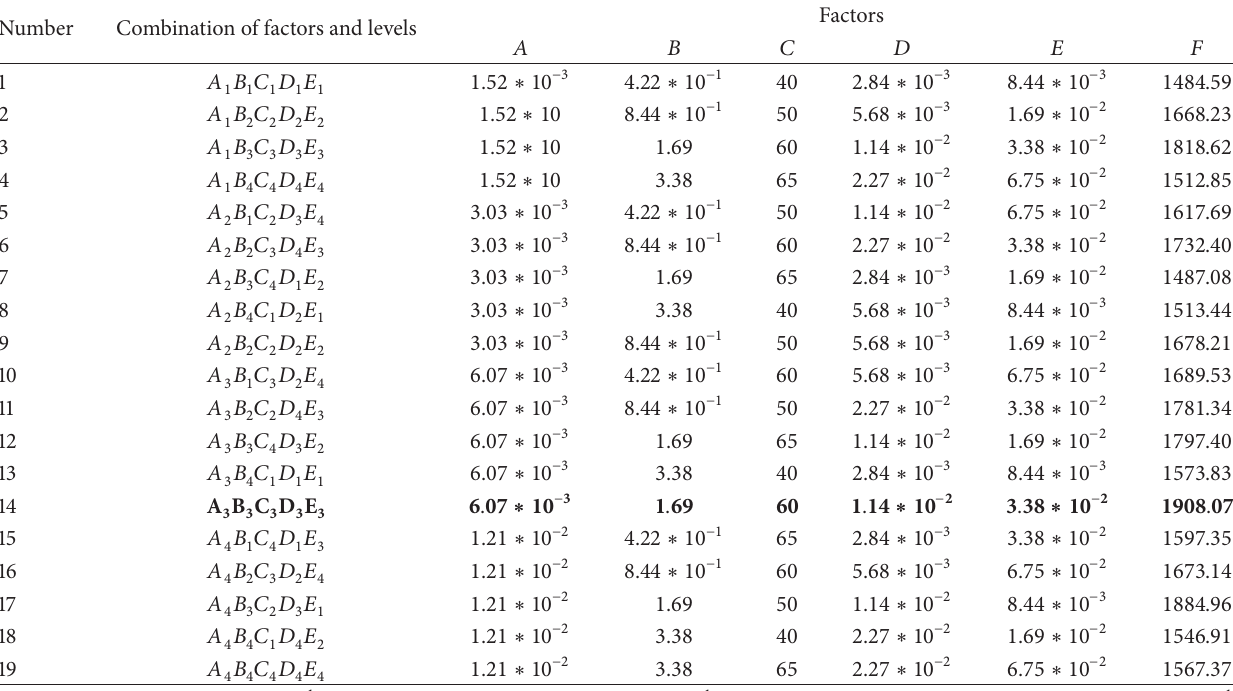
Table 11: Results of synthesis.